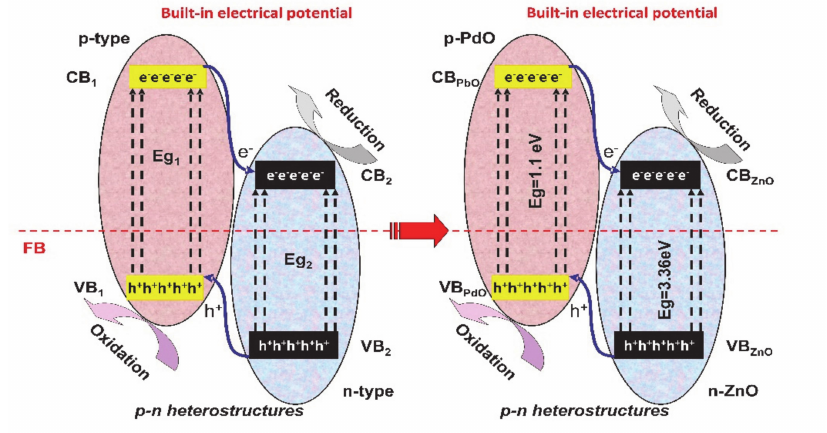
Figure 2. The p-n junction’s mechanism.